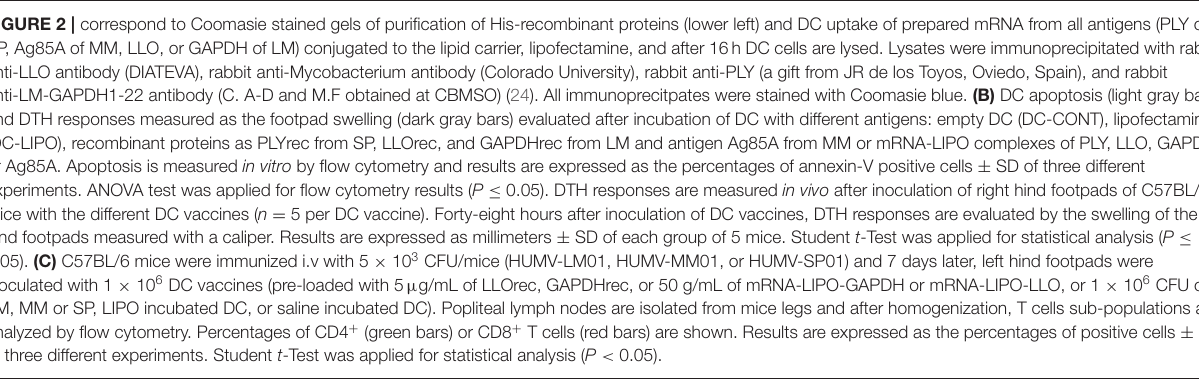
TABLE 1 | Main bacteria detected at Hospital Universitario Marqués de Valdecilla yearly with GAPDH showing more than 80% sequence homology at N-terminus. a